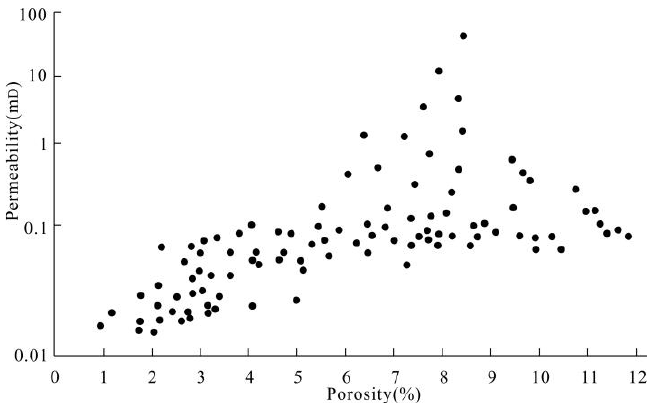
Figure 4. Diagram of the relationship between permeability and porosity.